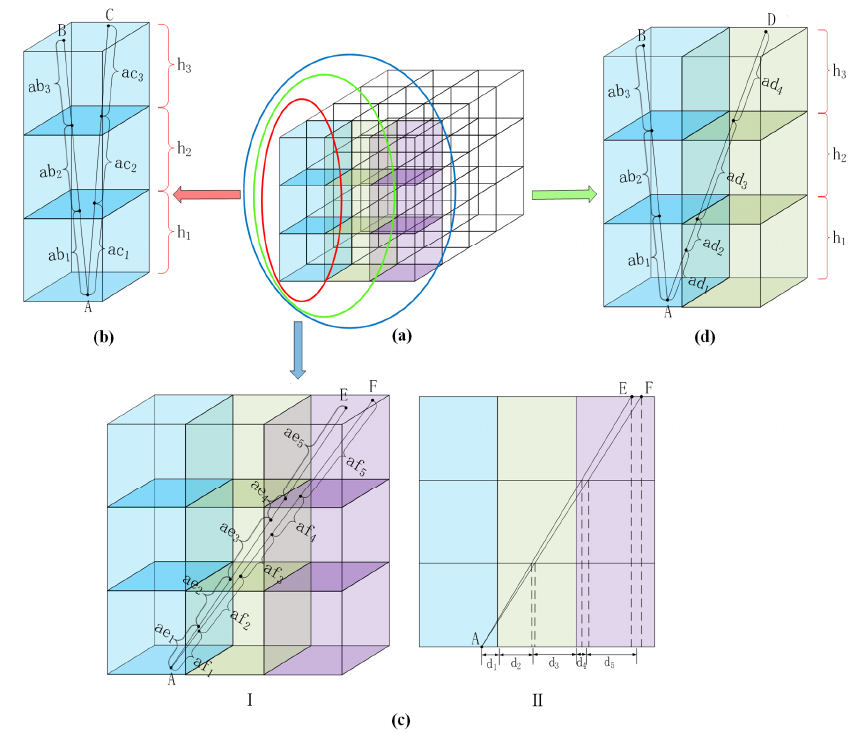
Figure 3. Di ff erence between valid and characteristic signals: ( a ) a tomography area composed of voxels, with one column of voxels circled in red, whereas two columns of voxels are circled in green and three columns of voxels are in purple circle; ( b ) visualization of valid signals (A–B) and (A–C); ( c ) visualization of valid signals (A–E) and (A–F); ( d ) visualization of characteristic signals (A–B) and